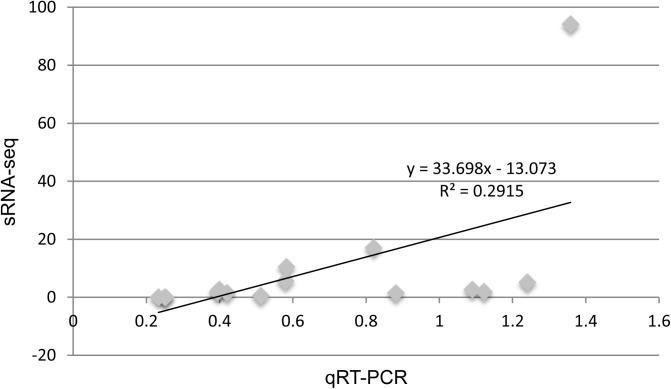
Validation of the expression profiles of conserved and novel miRNAs.The scatterplot of miRNA expression shows the correlation between small RNA sequencing (sRNA-seq) and qRT-PCR results.